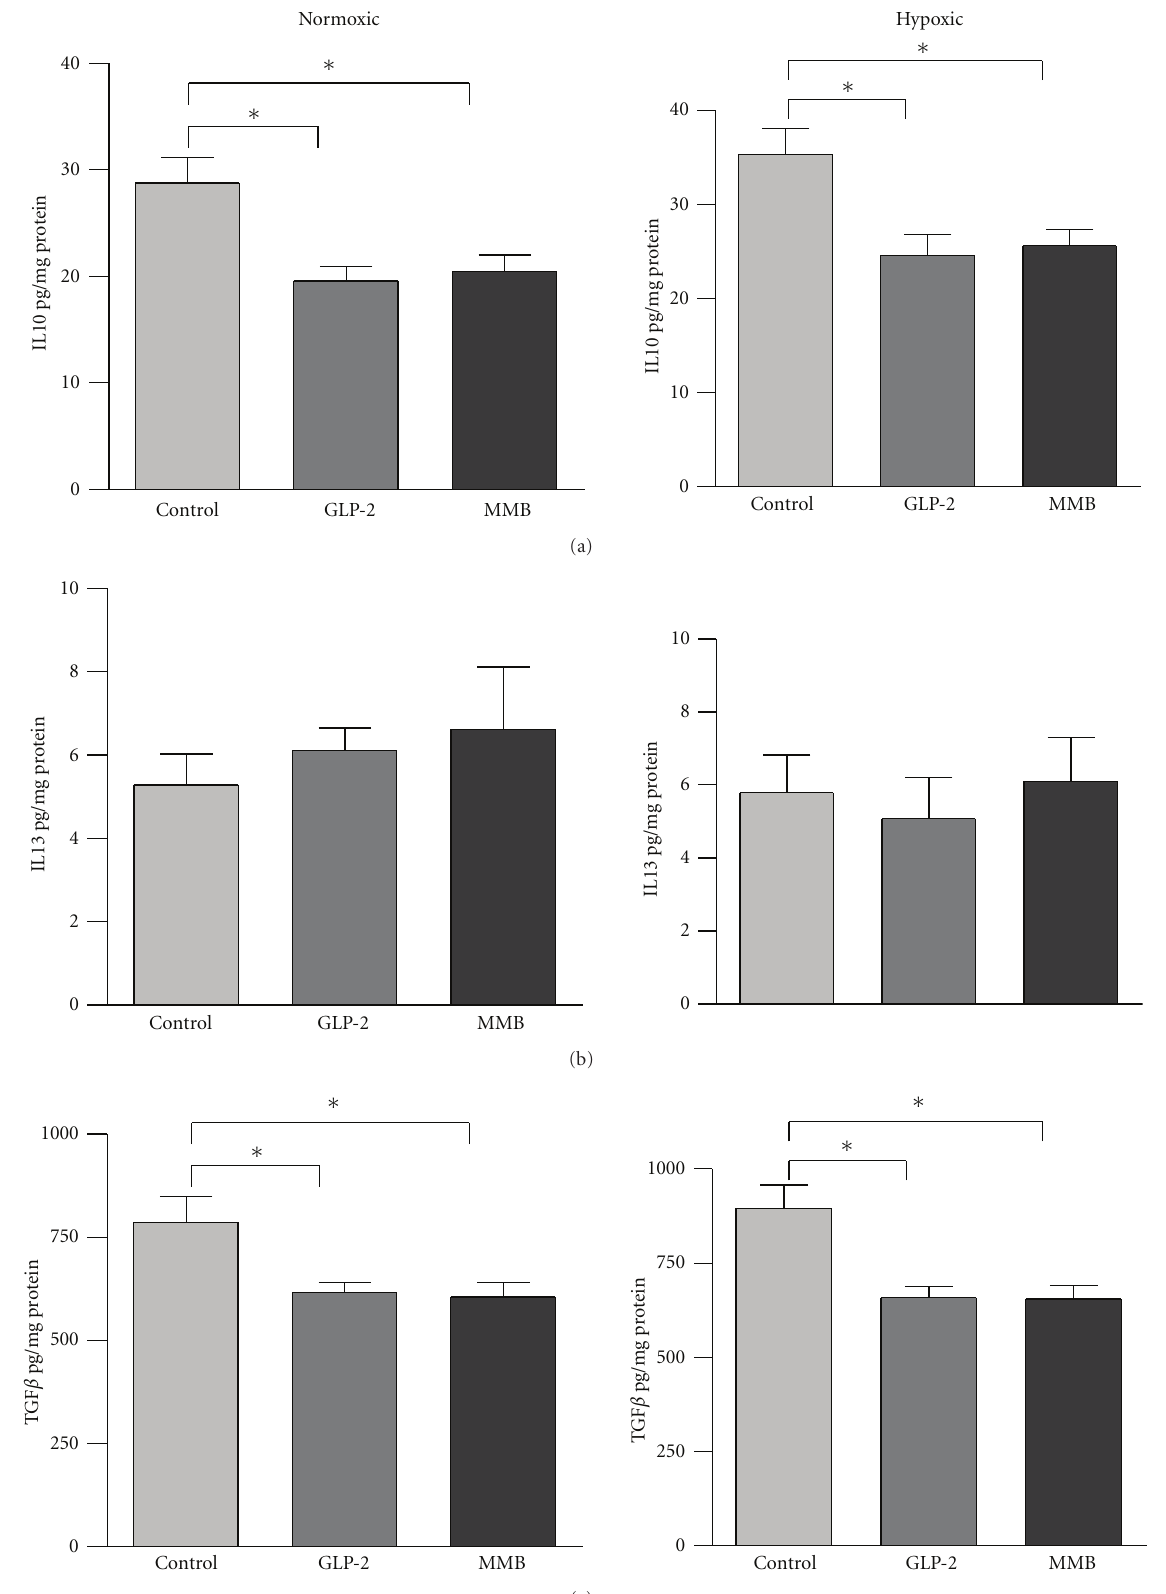
Figure 5: Levels of anti-inflammatory/prohealing cytokines. (a) IL-10, (b), IL-13, and (c) TGF β from anastomosed colon as determined by ELISA and normalized to protein content. Data: mean ± SEM, n = 7 or more per group, ∗ P < . 05 by